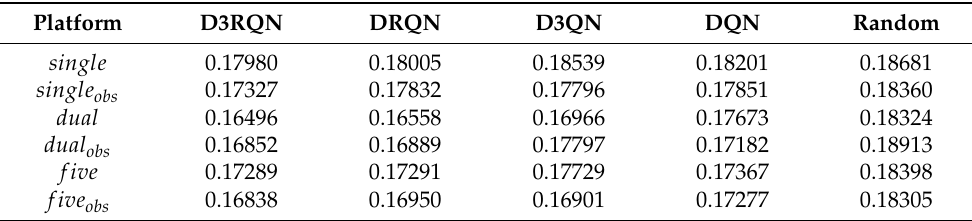
Table 4. Summer: RMSE comparison of sampling and assimilation results of the observation path between a single platform and multiple platforms, RMSE raw = 0.21733.